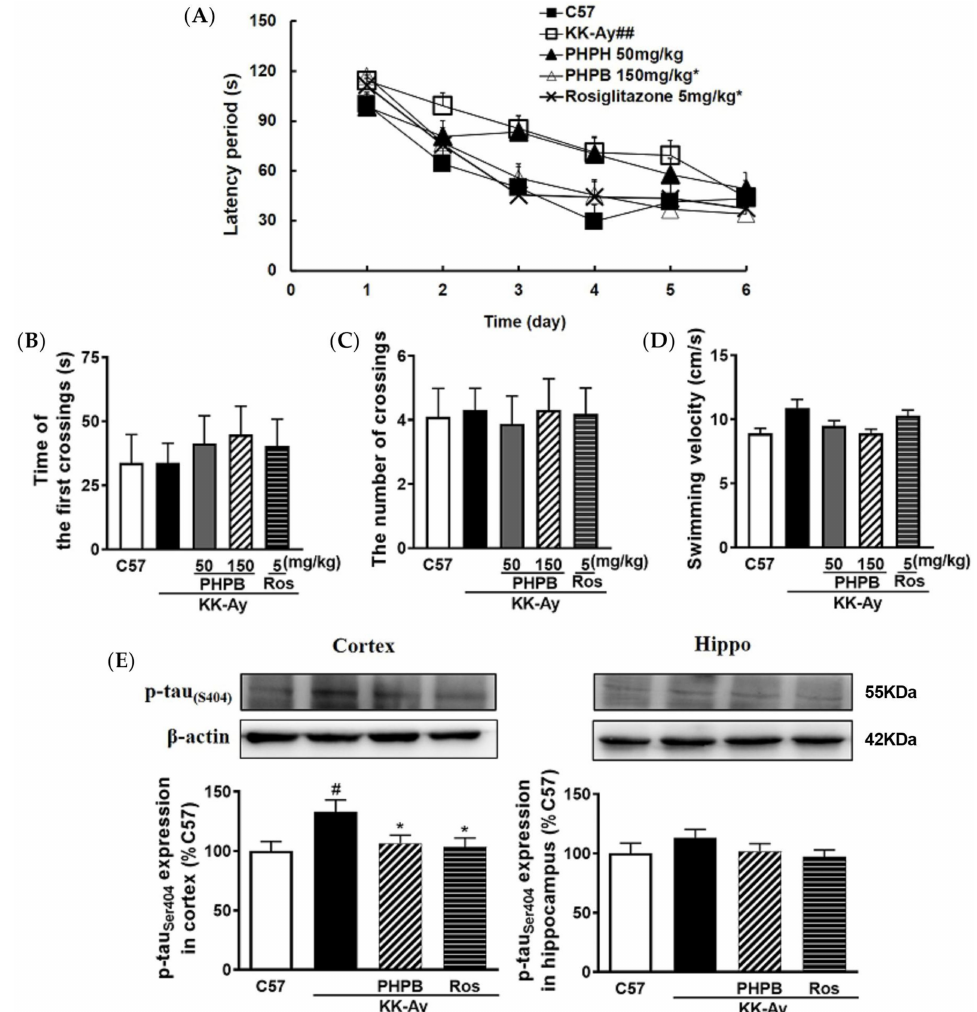
Figure 3. PHPB attenuated cognitive impairment in type 2 diabetic KK-Ay mice. KK-Ay mice were treated with PHPB (50 mg/kg or 150 mg/kg or rosiglitazone (Ros, 5 mg/kg) for two months by oral gavage. The performance of the Morris water maze was tested among all groups. ( A ) Spatial learning performance was analyzed by escape latency for mice to locate the hidden platform during the 6-days acquisition training. In the probe trial test on the seventh day, ( B ) the first latency time and ( C ) the times of crossings over the original platform location, and ( D ) the swimming velocity were recorded to evaluate the spatial memory maintenance/movement ability, n = 10–19 for each